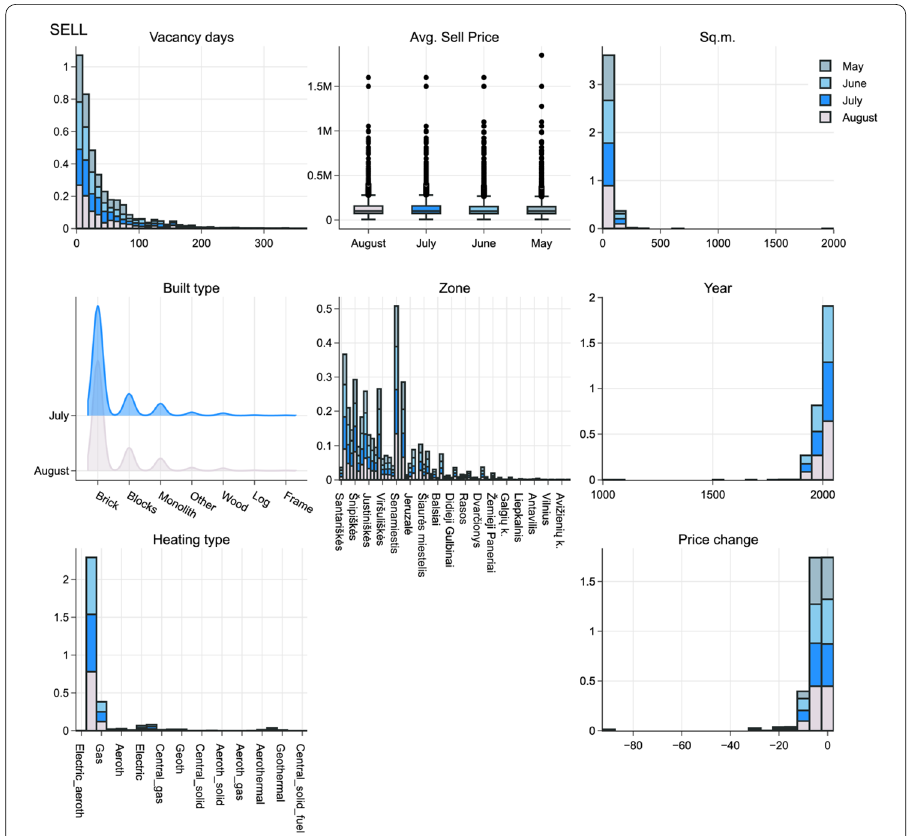
Fig. 4 Summary statistics of sell